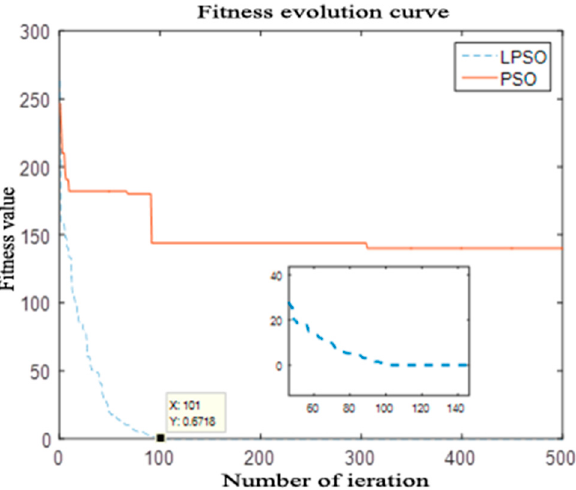
Figure 19. The fitness curve of the Rastrigin